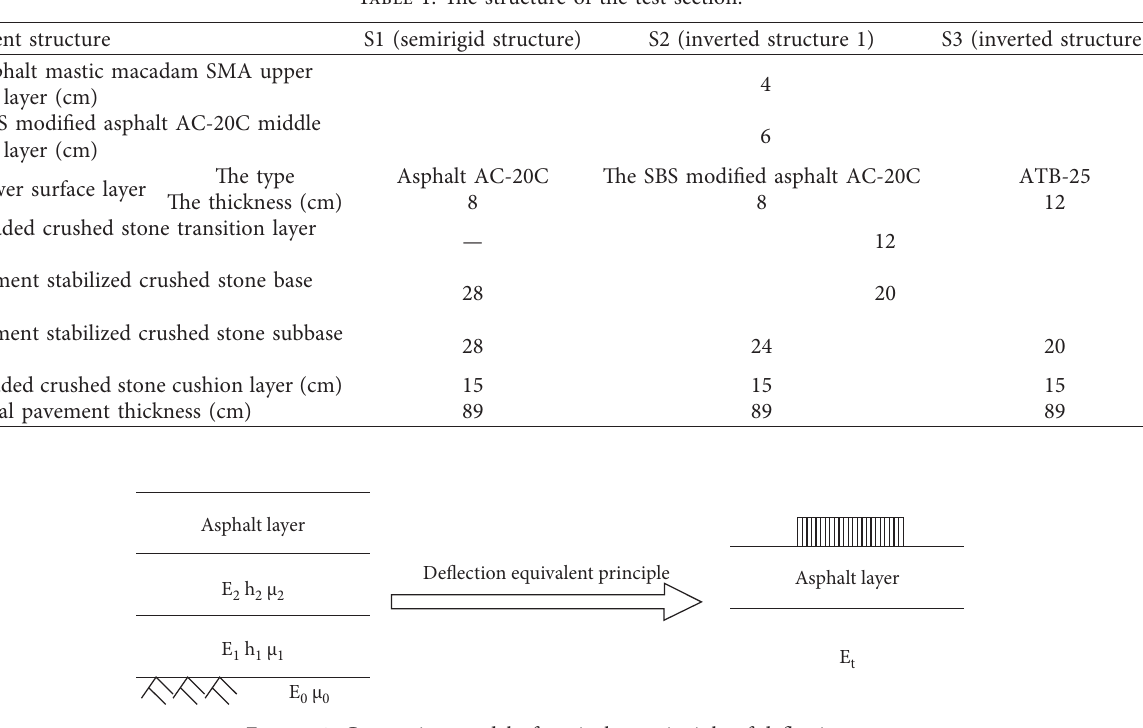
Table 1: The structure of the test section.